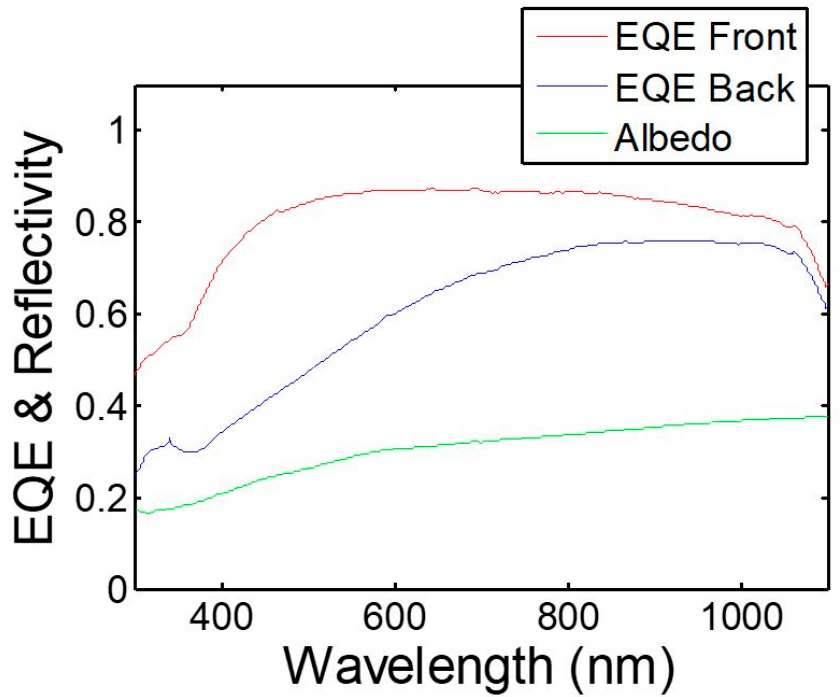
Figure 2. External quantum efficiency (EQE) curves measured for the front and rear surfaces of a bifacial solar cell and ground reflectivity, as a function of the wavelength ( λ ), used for the calculations in the present study. Such curves were used in Reference [10] to validate the model here described, through experiments performed outdoor on bifacial PV mini-modules consisting of four solar cells in series.